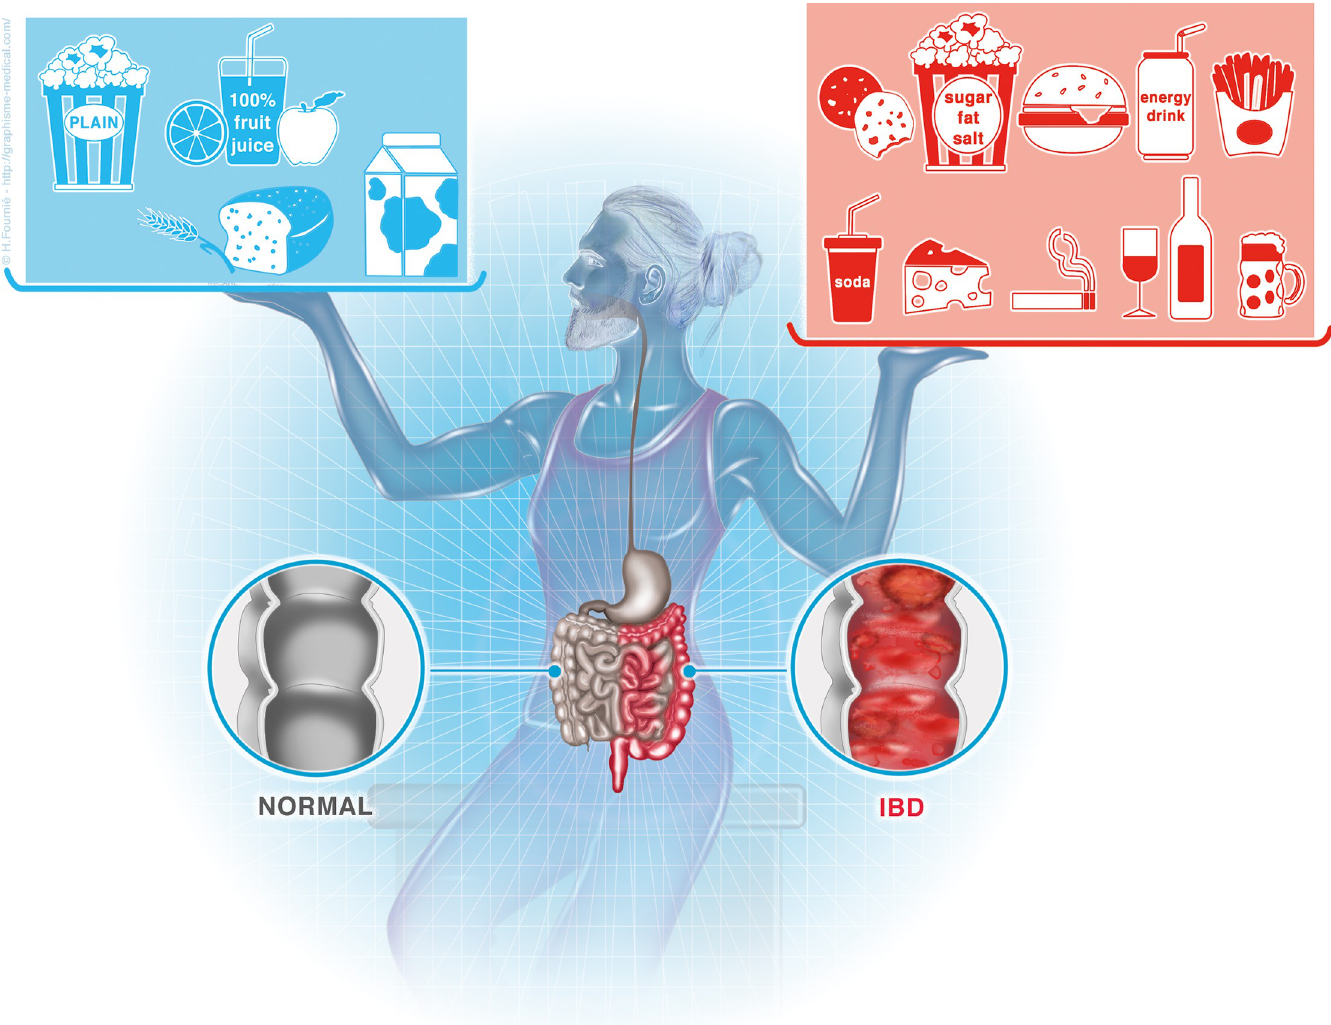
Fig 4. Simple illustration of food items found to be associated with IBD prevalence in estimated US adult population from the assessment of NHIS 2015. This figure does not imply or establish causal relationship of food items assessed with IBD. The picture only depicts general association found in this current study.